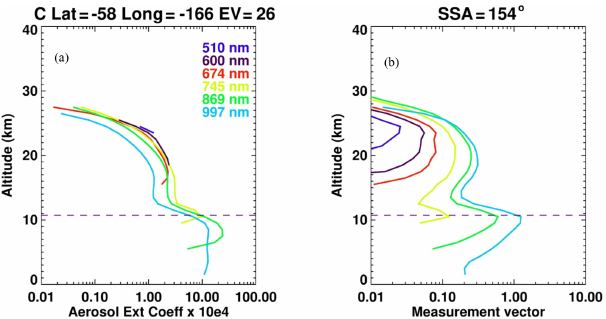
Figure 1. Panel (a) is a plot of retrieved OMPS LP aerosol extinc- tion profiles ( × 10 4 km − 1 ) colored by wavelength for event 26 in the SH measured on 12 April 2018. Panel (b) is the aerosol scatter- ing index (ASI) or measurement vectors ( y ) for the same event. The dashed line is the tropopause